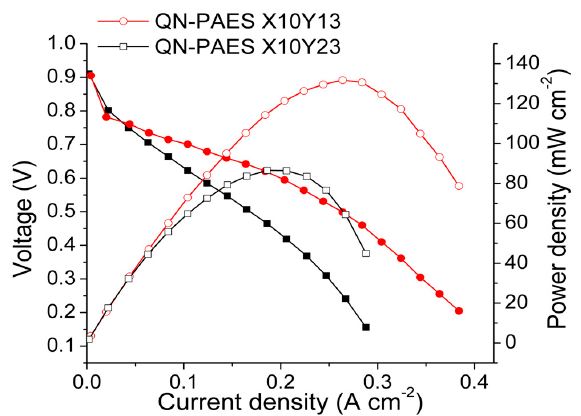
Figure 12. The polarization curves of QN-PAES X10Y23 and X10Y13 at 60 ◦ C under fully humidified H 2 /O 2 conditions.